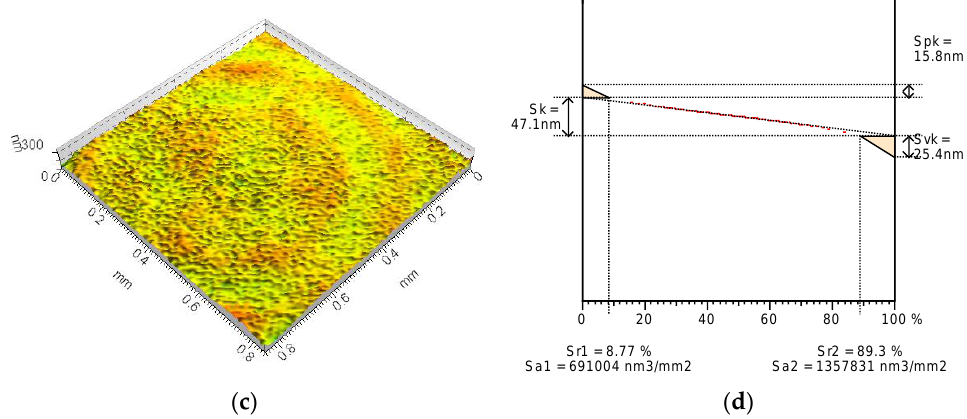
Figure 2. Modified surface no. 2 (3D view) ( a ) and Abbott-Firestone curve with Sk-family parameters ( b ).